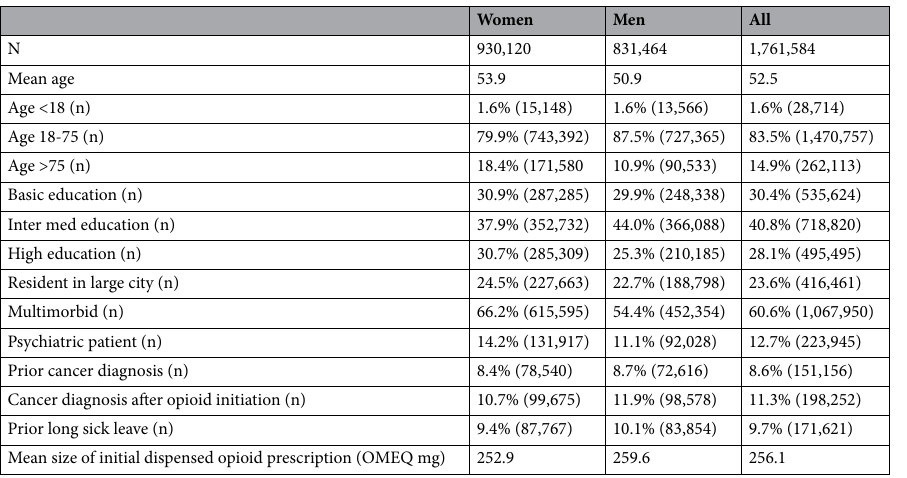
Table 2. Baseline characteristics at initiation of opioid therapy for all opioid users in Finland in 2009–2017 (n = 1 761 584).